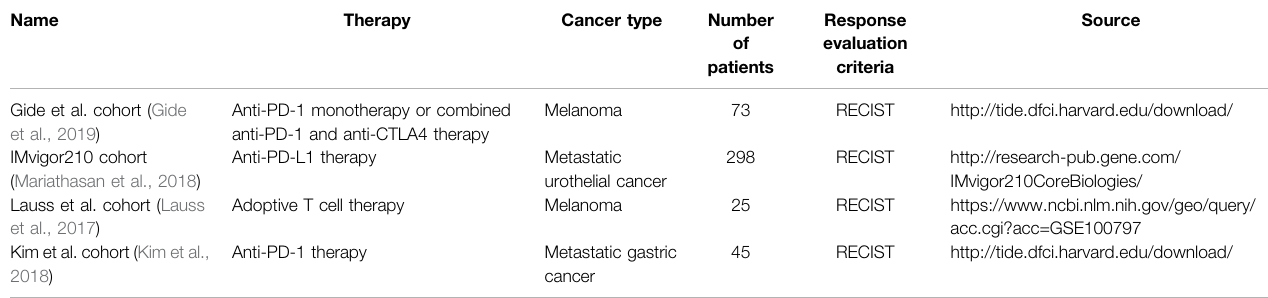
TABLE 1 | Details of immunotherapy